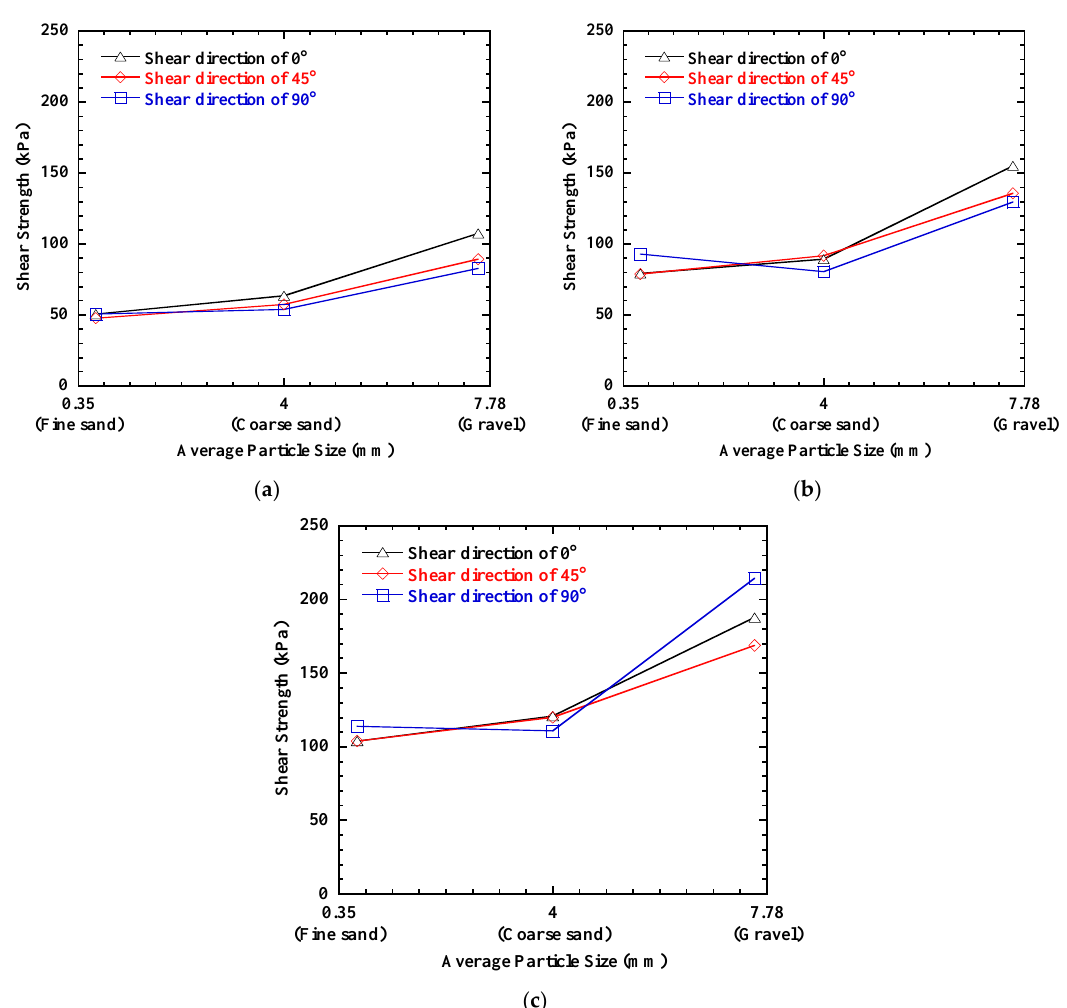
Figure 16. The influence of particle size on the shear strength of soil–triaxial geogrid (TX150) interfaces. ( a ) Normal stress of 50 kPa, ( b ) normal stress of 100 kPa, ( c ) normal stress of 150 kPa.